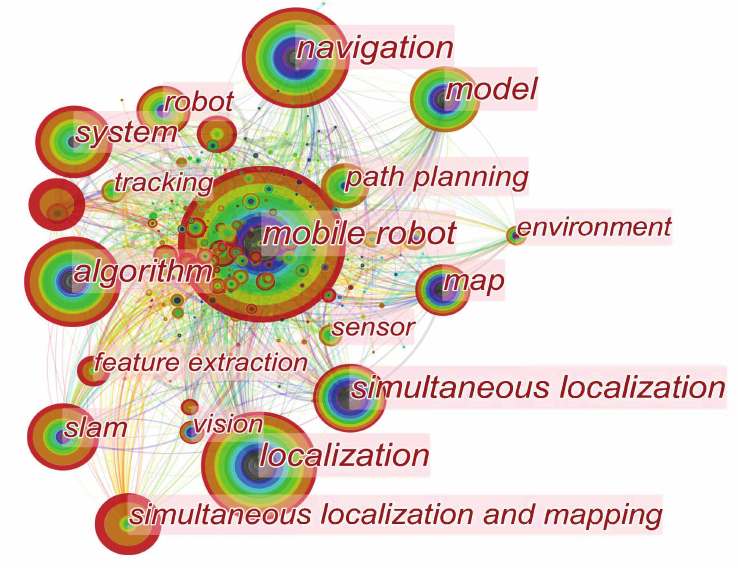
Figure 4. Hot words in mobile robot field.